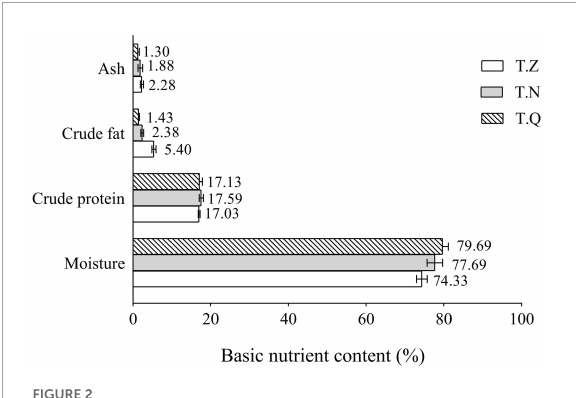
T.Z had the highest ash content (2.28%). The three samples had approximative protein percentages (17.03–17.59%). The